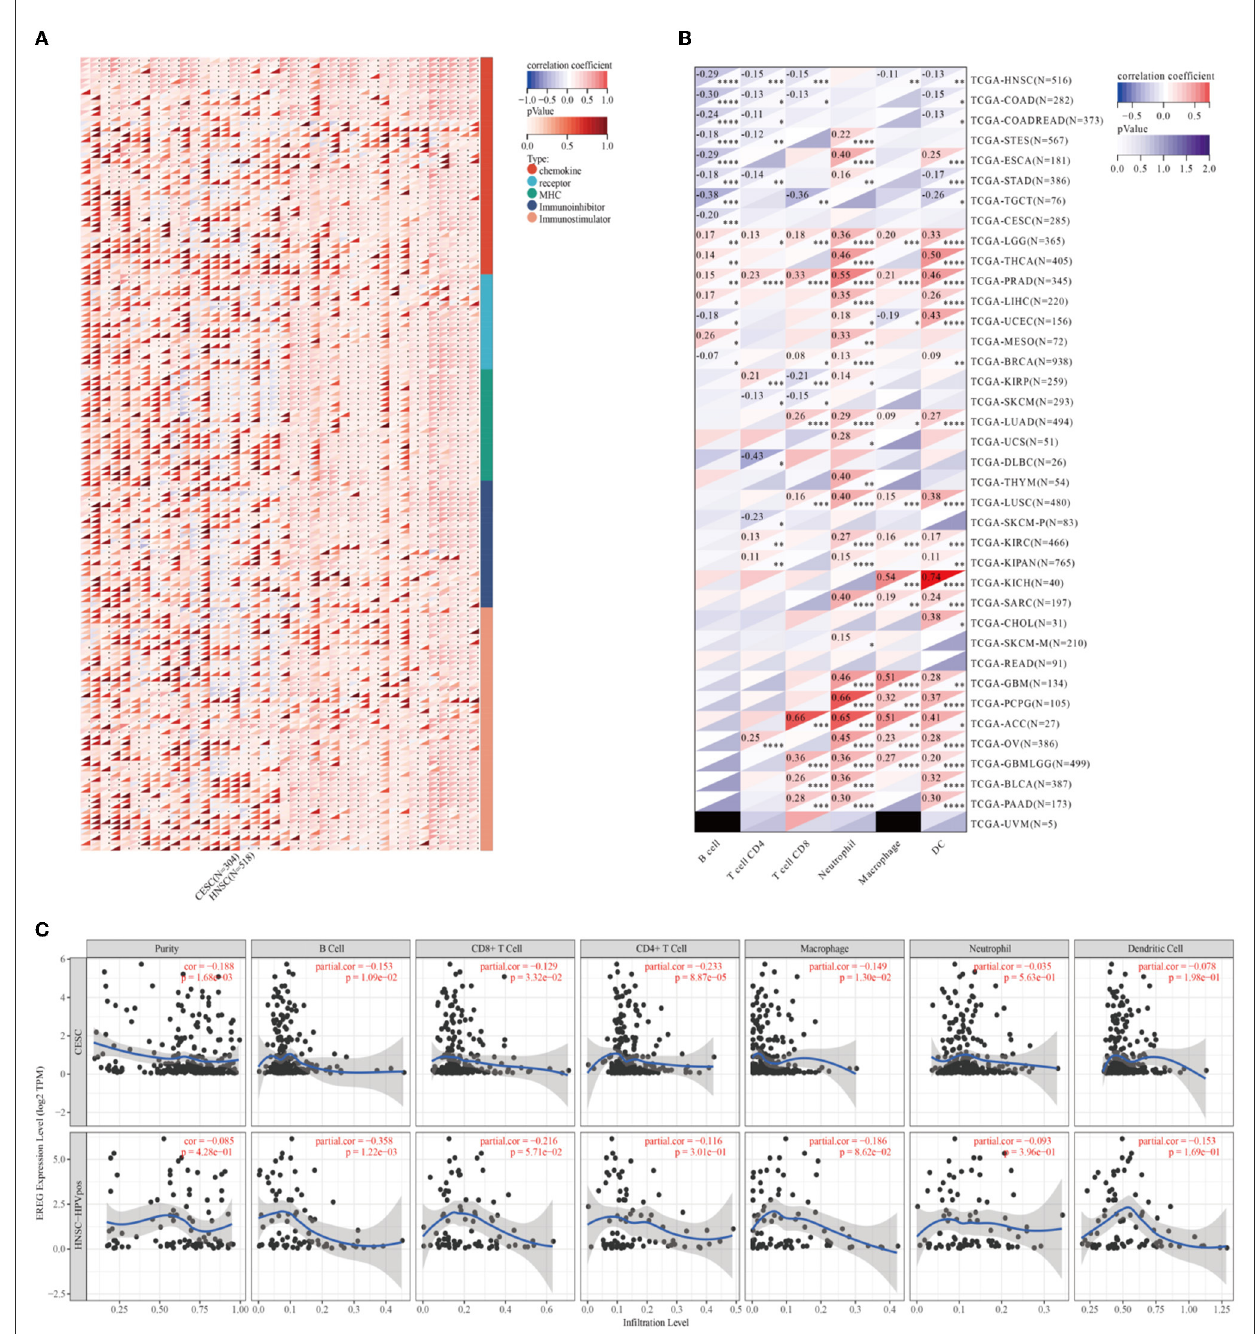
FIGURE6 Immune-associated analysis of EREG in Pan-Cancer, cervical cancer, and HPV positive head and neck squamous cell cancer. (A) The map represents the relationship between EREG expression and the expression of immune regulatory genes. The types of genes were divided into chemokine, receptor, immunoinhibitory, and immunostimulator. (B) The correlation between immunocyte infiltration and expression of EREG in Pan-Cancer. (C) The correlation between immunocyte infiltration and expression of EREG in cervical cancer and HPV-positive head and neck squamous cell cancer. “*” represents p < 0.05, “**” represents p < 0.01, “***” represents p < 0.001, and “****” represents p <